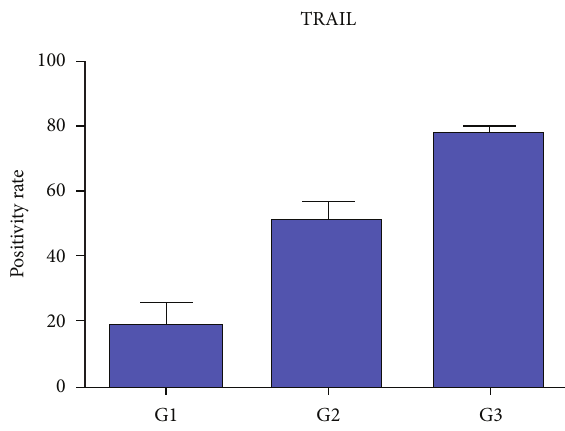
Figure 2: Poorly differentiated cases showed a higher percentage of TRAIL expressing cells in comparison to well-differentiated ethmoidal